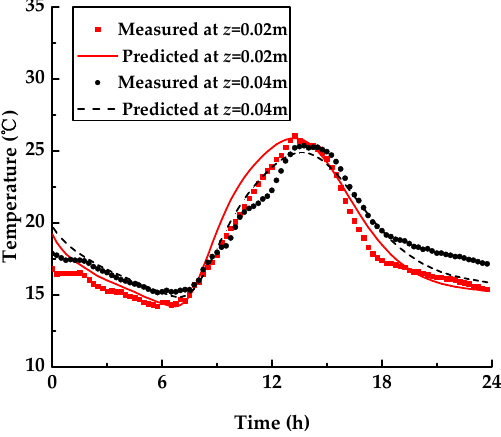
Figure 7. Measured and predicted temperature at z = 0.35 m and z = 0.55 m on 24 August.